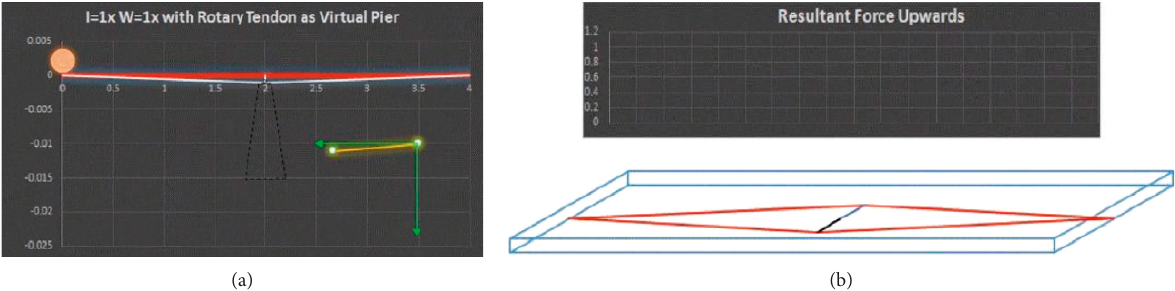
Figure 2: Rotation angle and upwards resultant force for the first stage of a bridge with the NEM.